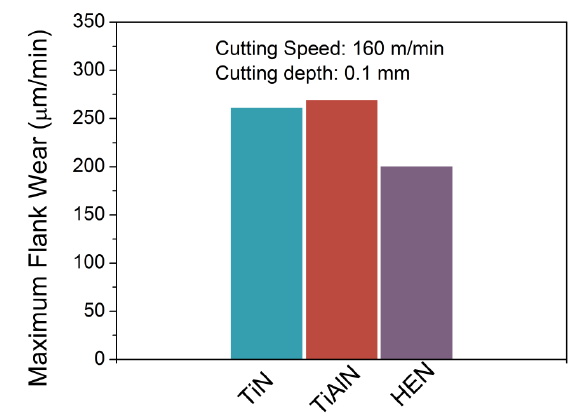
Figure 11. The comparison of maximum flank wear among TiN-, TiAlN-, and HEN-coated inserts after continuous milling tests against 304 stainless steel for a cutting distance of 900